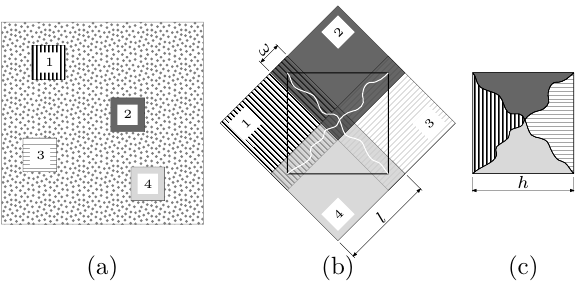
√ n cs many Figure 7. Binary scans of existent samples (Fig. 6) of aluminum foam [11]. The order of images corresponds to the order of subsequent cuts of larger